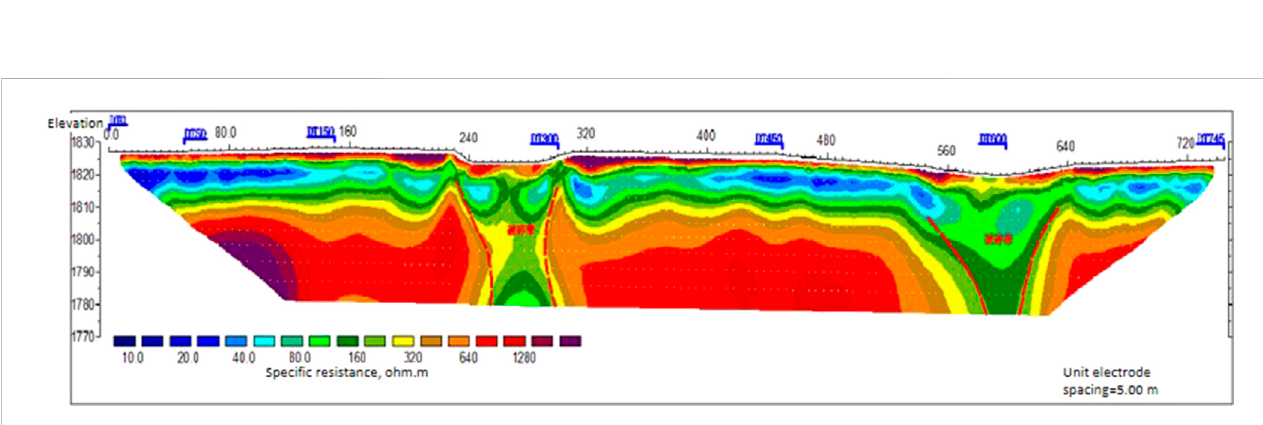
FIGURE 8 Typical pro fi le of high-density electrical method in the K179+400~K181+466 interchange